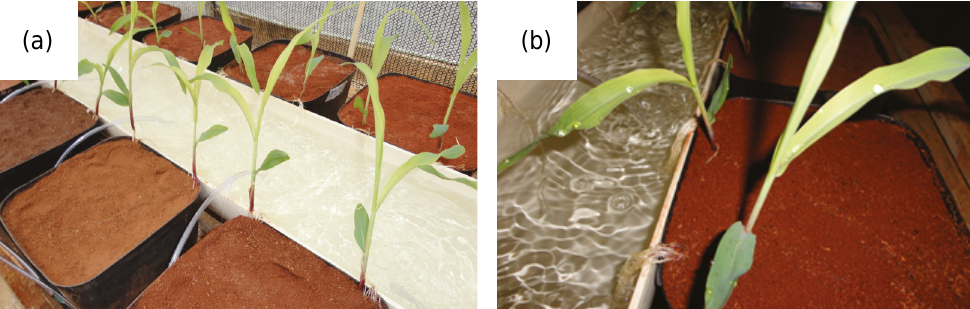
Figure 1. Semi-hydroponic system of pots paired to the center channel (a), with the plant roots growing in both containers